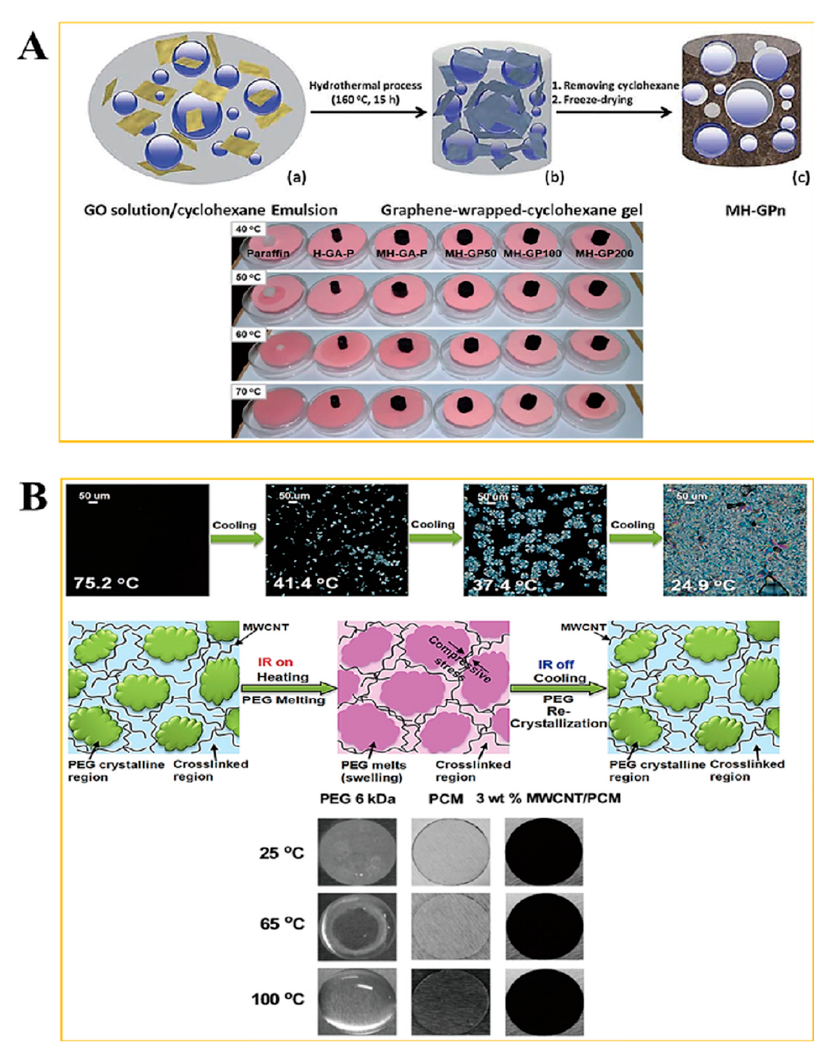
Figure 3. ( A ) paraffin microencapsulated PCM composite ( B ) cross ‐ linked PEG form stable structure.